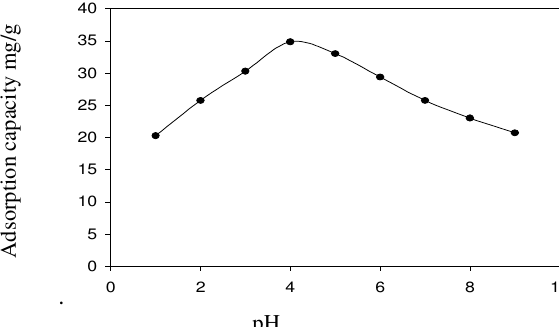
Figure 2 . Effect of pH on adsorption of Cr(VI) on trametes versicolor polyporous fungi